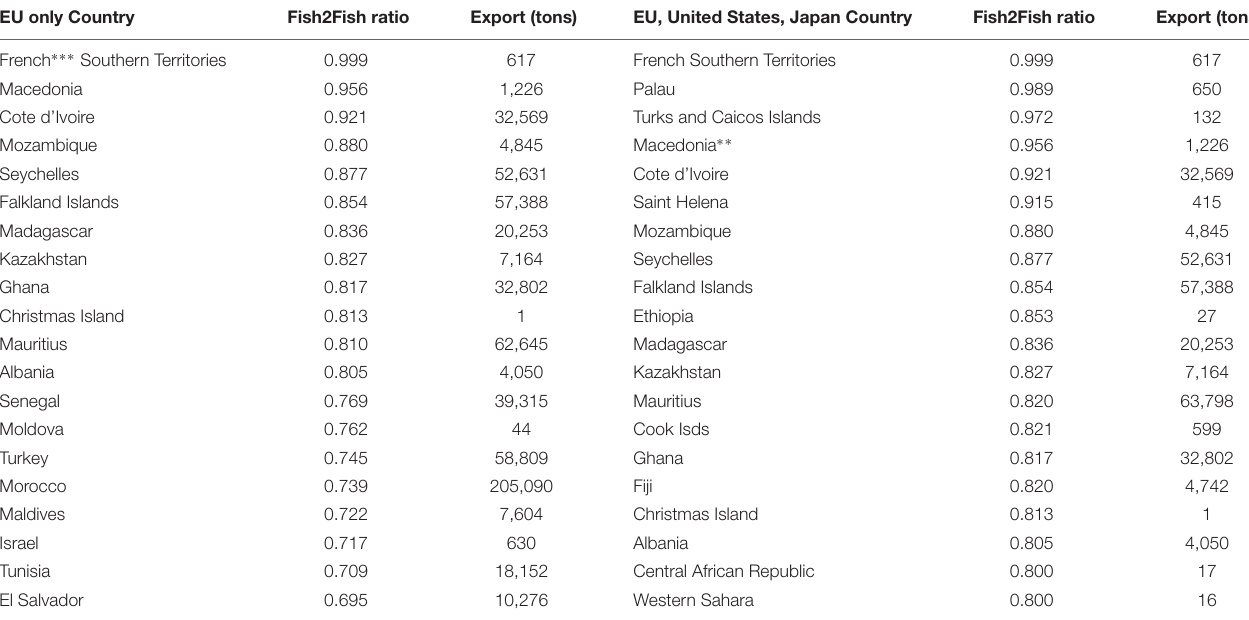
TABLE 3 | Top Fish2Fish ratio ∗ of fish exporting countries to the EU only and to the EU, the United States and Japan combined. EU only Country